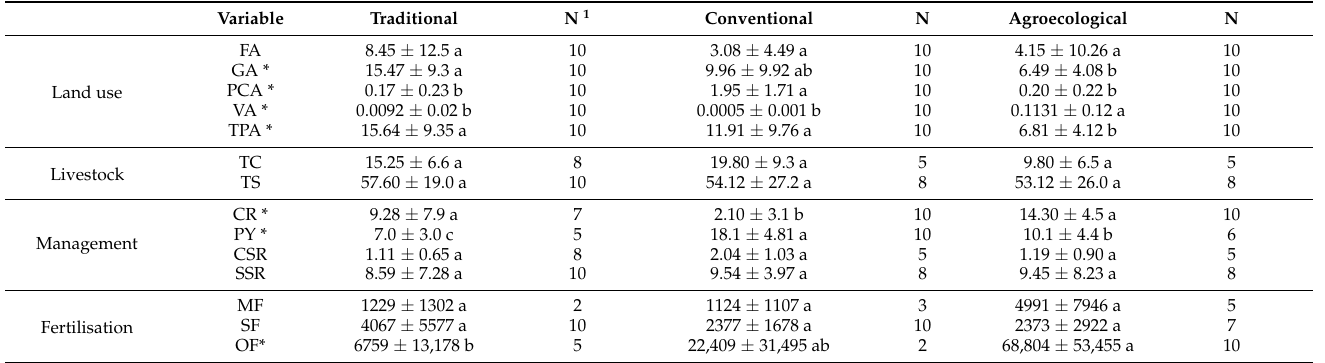
Table 2. Mean ± SD of variables associated with productive activities for the different agricultural